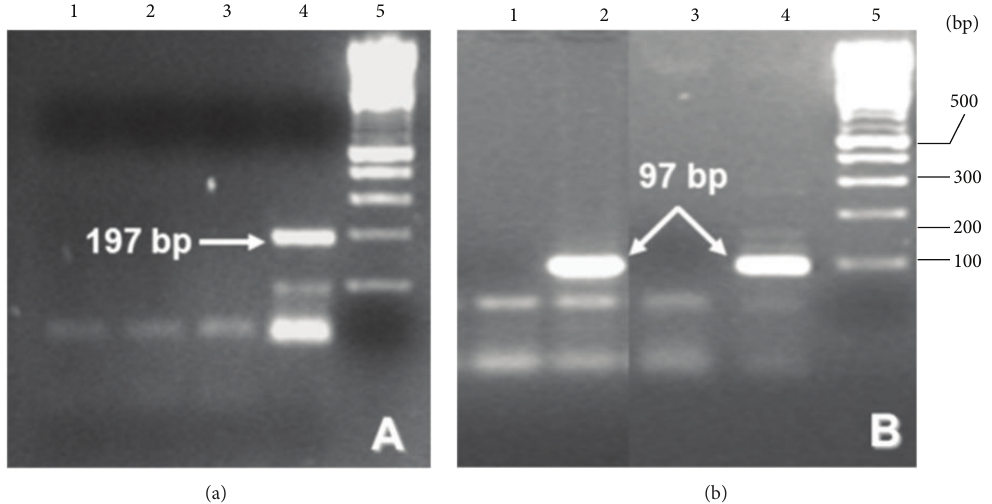
Figure 6: Molecular detection of T. gondii by nested -PCR of a B1 gene sequence. (a) First round PCR and (b) nested -PCR. Line 1: DNA from PF- and PE-sections of the frontal lobe SOL; line 2: DNA from PF- and PE-liver sections from a T. gondii experimentally infected mice; line 3: distilled water as a negative control; line 4: DNA from tachyzoites of T. gondii (RH strain); and line 5: 100bp DNA ladder as molecular